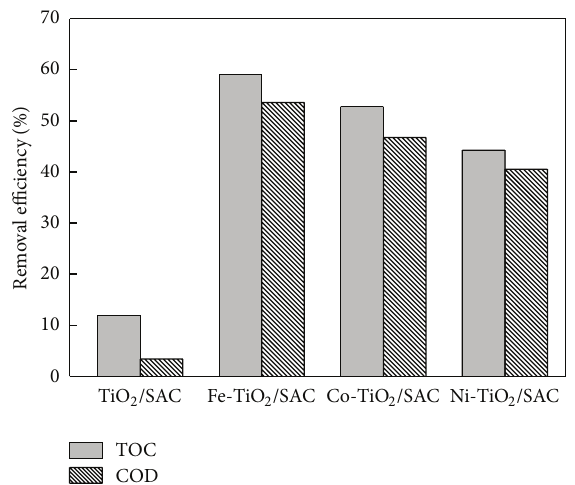
Figure 6: TOC and COD removal on the photocatalytic degra- dation of humic acid by TiO 2 /SAC and various transition metal doped-TiO 2 /SAC under light irradiation with wavelength range of (a) 100 ∼ 280nm and (b) 315 ∼ 400nm for 6